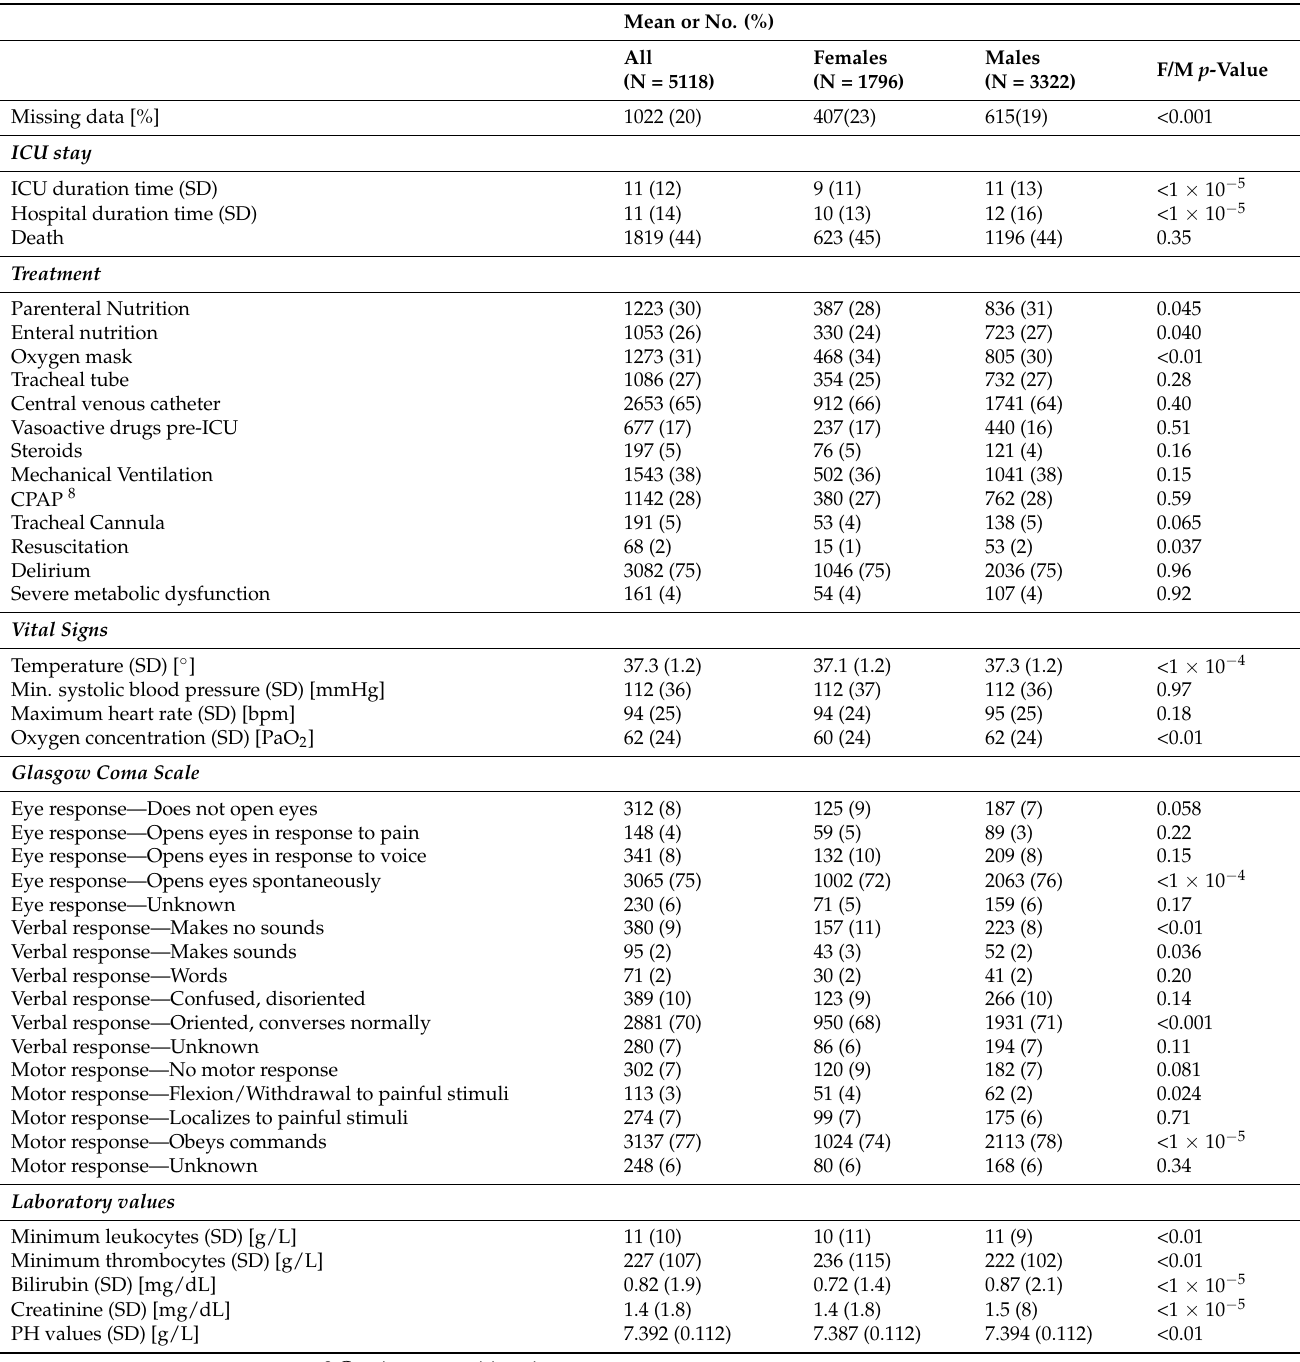
Table 2. Comparison of patients with Coronavirus Disease 2019 admitted to the intensive care unit (ICU) by sex. ICU characteristics. The number of patients with observed characteristics for categorical variables or mean value for continuous variables are shown as well as the relative numbers (%) or standard deviation (SD) in parentheses. p -value significance tests between values of both sexes are performed using Chi-squared test for categorical variables or t -test for continuous variables. Mean or No. (%) All (N = 5118)